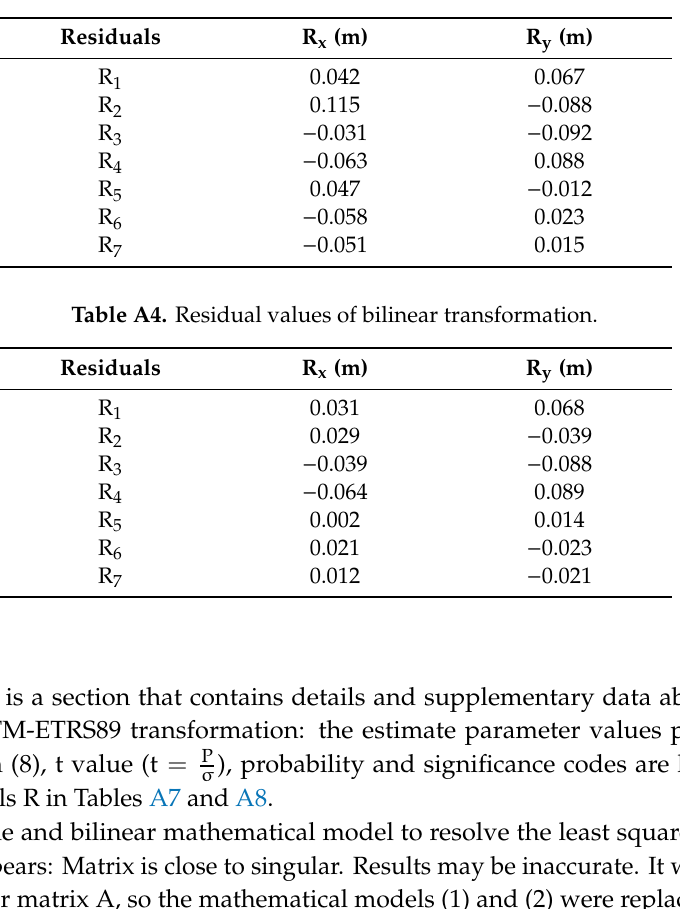
Table A3. Residual values of a ffi ne transformation.